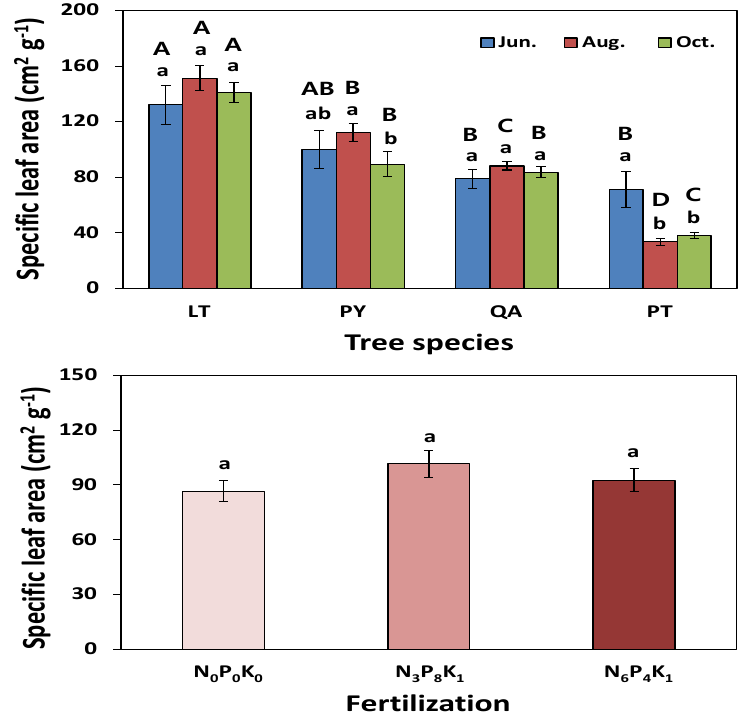
Figure 4. Specific leaf area of foliage by tree species and fertilization in a fire-disturbed urban forest (mean ± standard error). Treatment means with the same lower case letter among sampling month or fertilizer treatments and treatment means with the same upper case letter among tree species are not significantly different at p < 0.05. LT: Liriodendron tulipifera L.; PY: Prunus yedoensis Matsumura; QA: Quercus acutissima